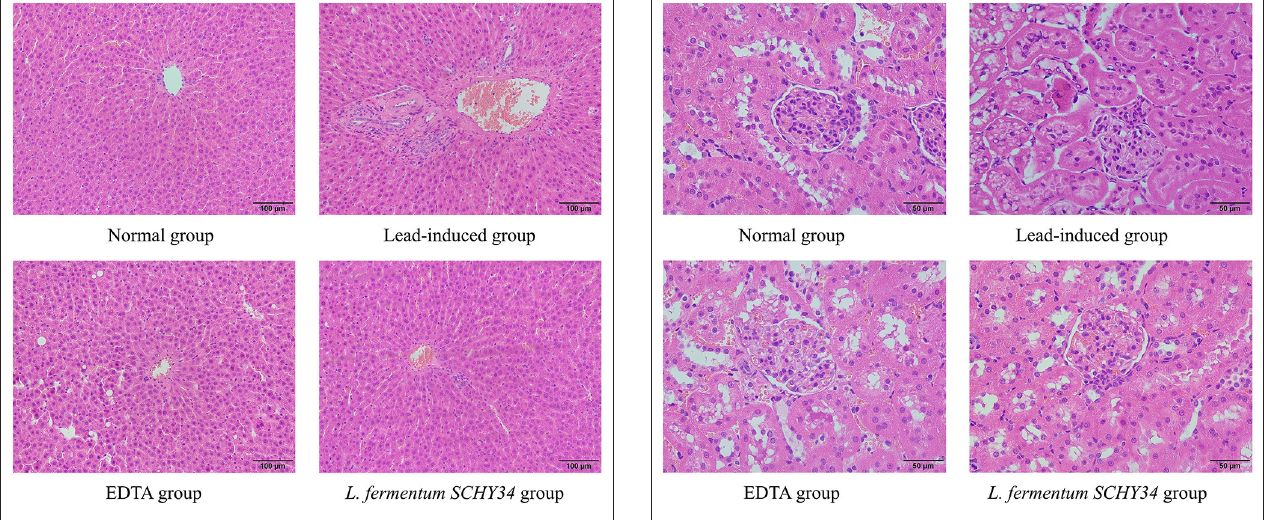
The neurons in the hippocampi of the normal group were arranged neatly and densely, the cell morphology was regular and complete, and the cytoplasm contained rich and dense Nissl bodies. The expression of astrocytes was strong, the number of cells was large, the cell body was large with dark brown-yellow staining, with thick and long protrusions, fewer branches, and a large proportion of cells. In the lead-induced rats, the CA1 area, CA3 area, and the hippocampal neurons of the dentate gyrus were scattered and loose, the neurons were missing, the shape was irregular, most were triangular or polygonal, the were reduced. The number and proportion of astrocytes in the